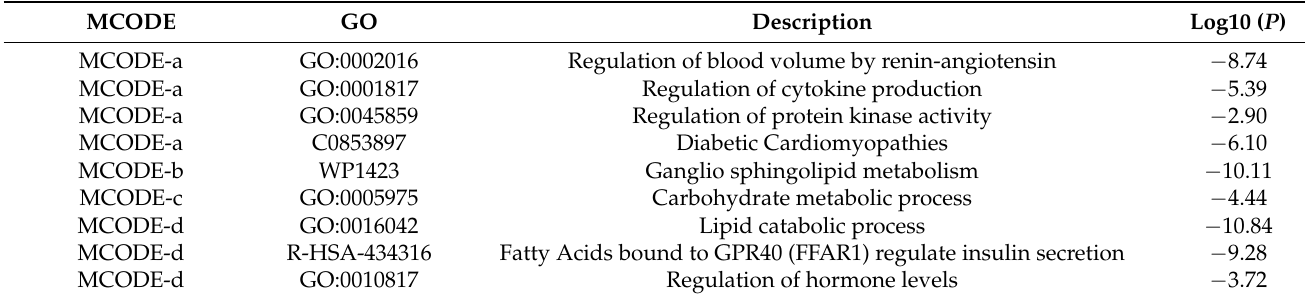
Table 2. Enrichment analysis of top 4 MCODE genes